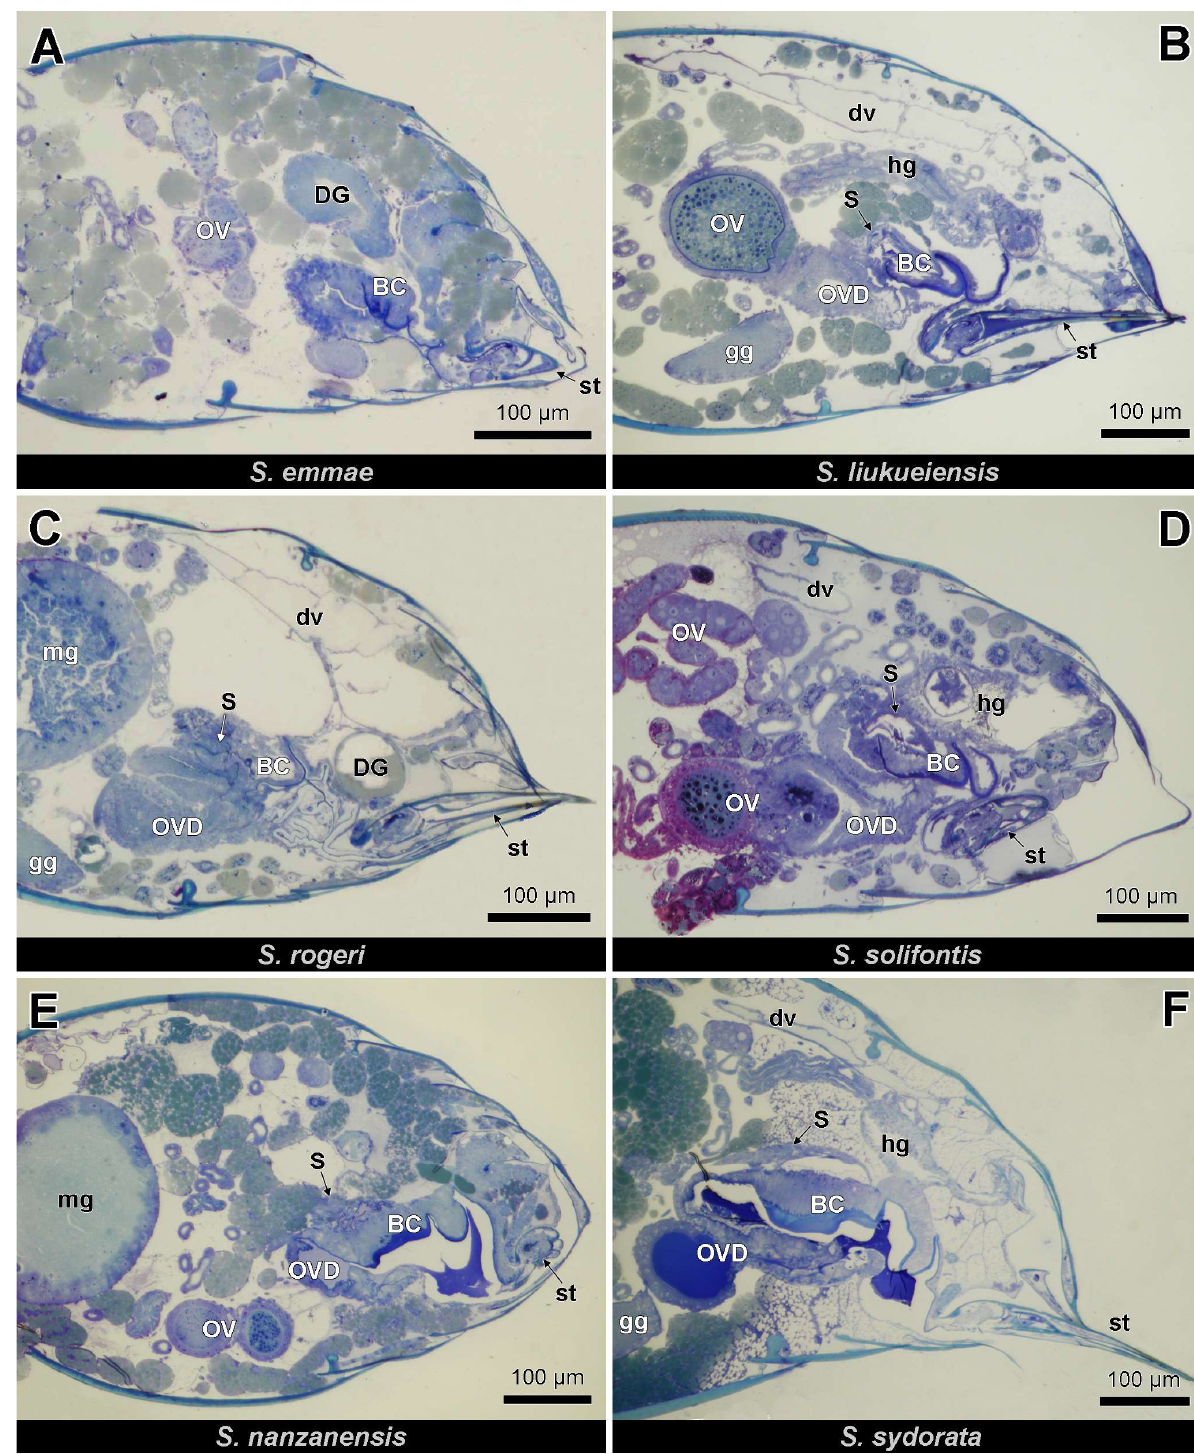
Figure 2. Semi-thin longitudinal sections (anterior to the left) of queen gaster in four parthenogenetic species ( A – D ) and two non-parthenogenetic species ( E , F ). BC: bursa copulatrix, DG: Dufour gland, dv: dorsal vessel, gg: ganglion, hg: hindgut, mg: midgut, OV: ovariole, OVD: oviduct, S: spermatheca, st: sting.